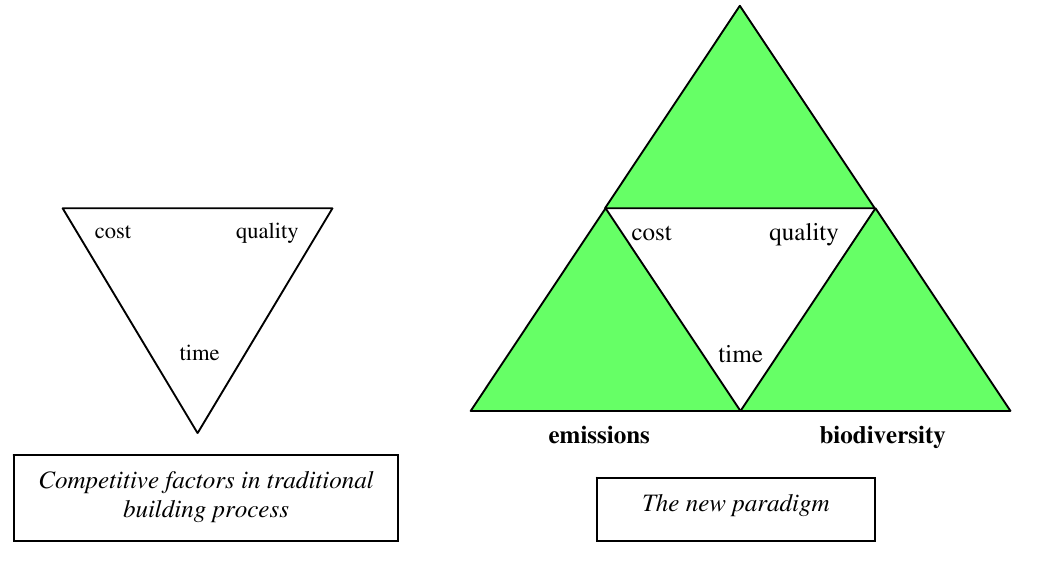
Fig 1. The new paradigm